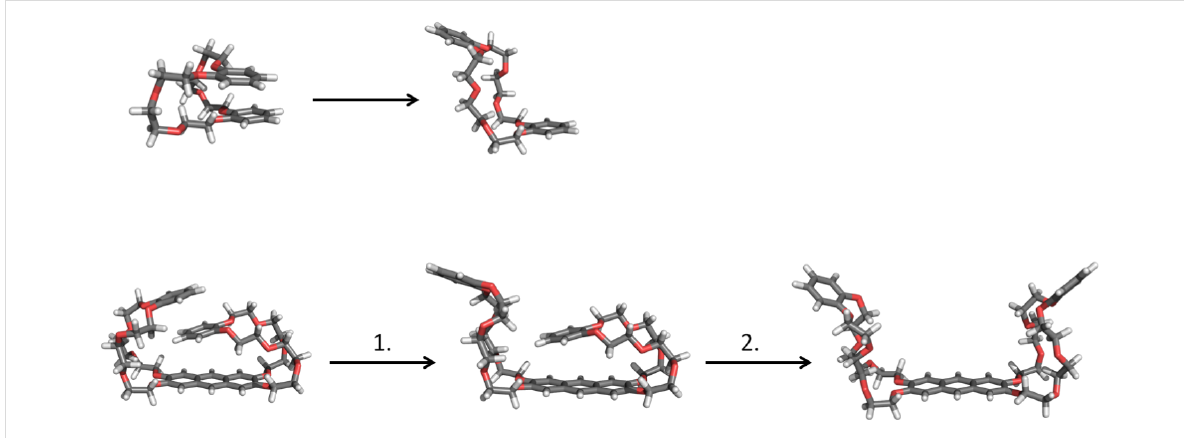
Figure 4: Optimized gas-phase structures for unfolding the monovalent (first row) and divalent (second row) host molecules. For the latter case a two- step process is